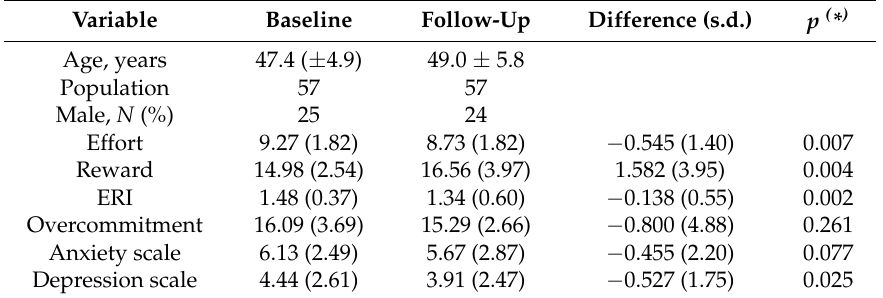
Table 3. Characteristics of the population. Levels of occupational stress and of anxiety and depression risk. Variable Baseline Follow-Up Difference